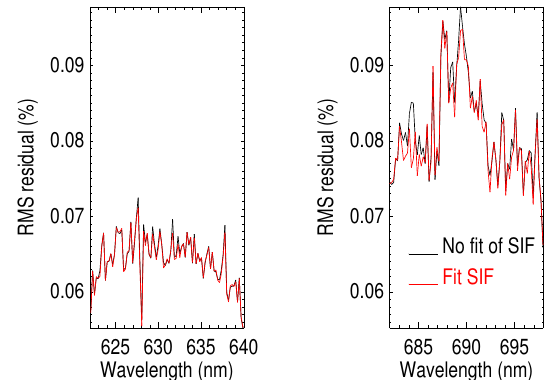
33.1 o N 92.5 o